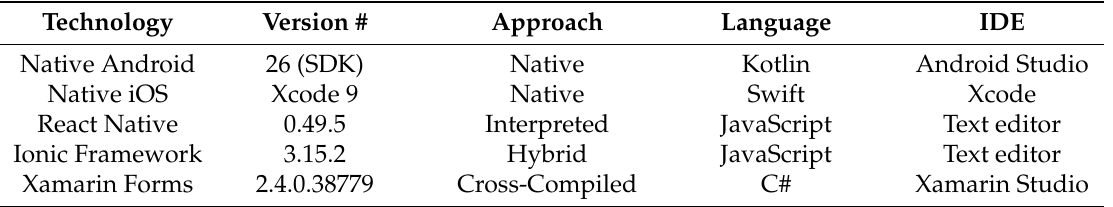
Table 1. Frameworks and Technologies Scrutinized.